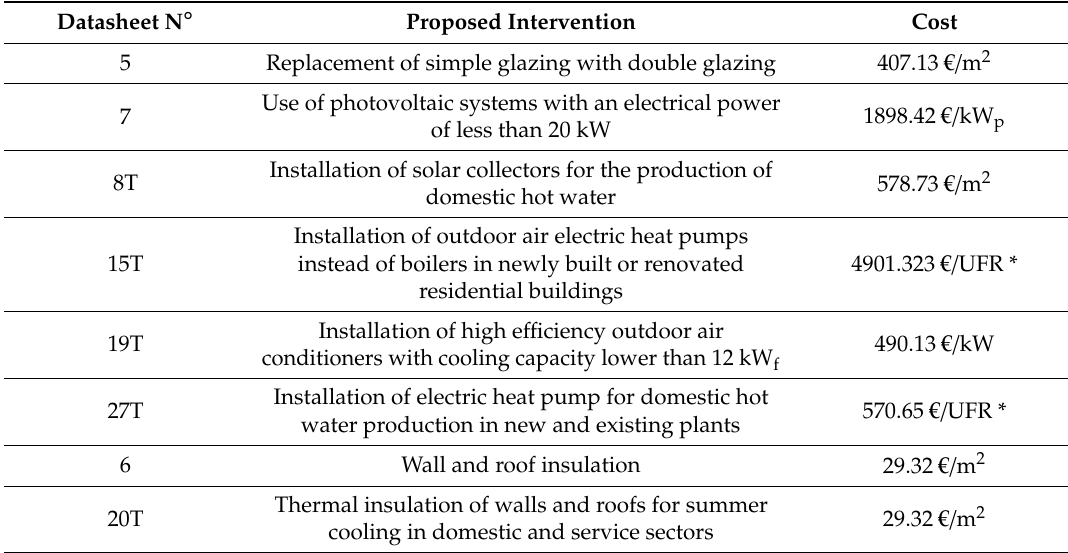
Table 4. ARERA technical datasheets proposed interventions